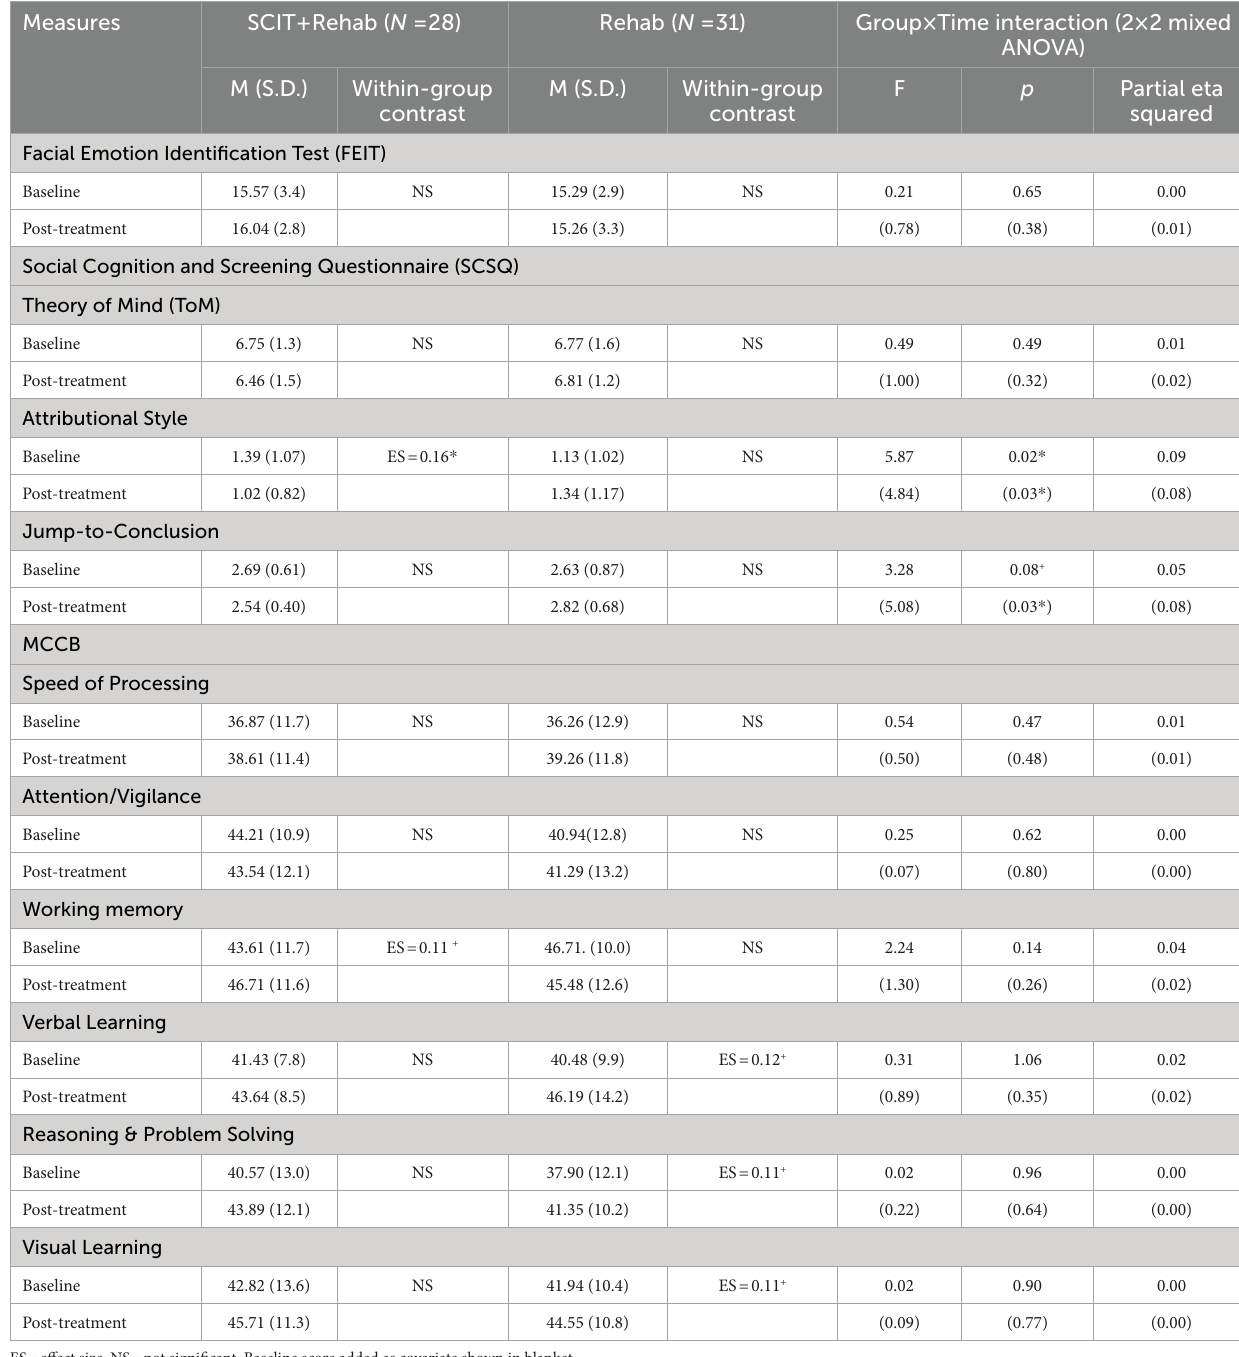
TABLE 3 Comparison of social cognitive and neurocognitive measures between SCIT + Rehab completers and Rehab group at T1 and T2. Measures SCIT + Rehab ( N = 28) Rehab ( N = 31) Group × Time interaction (2 × 2 mixed